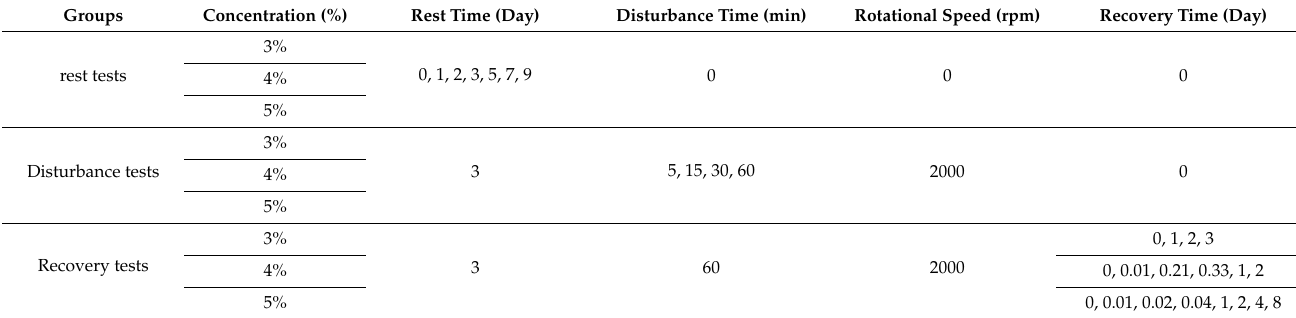
Table 1. Design of test conditions.